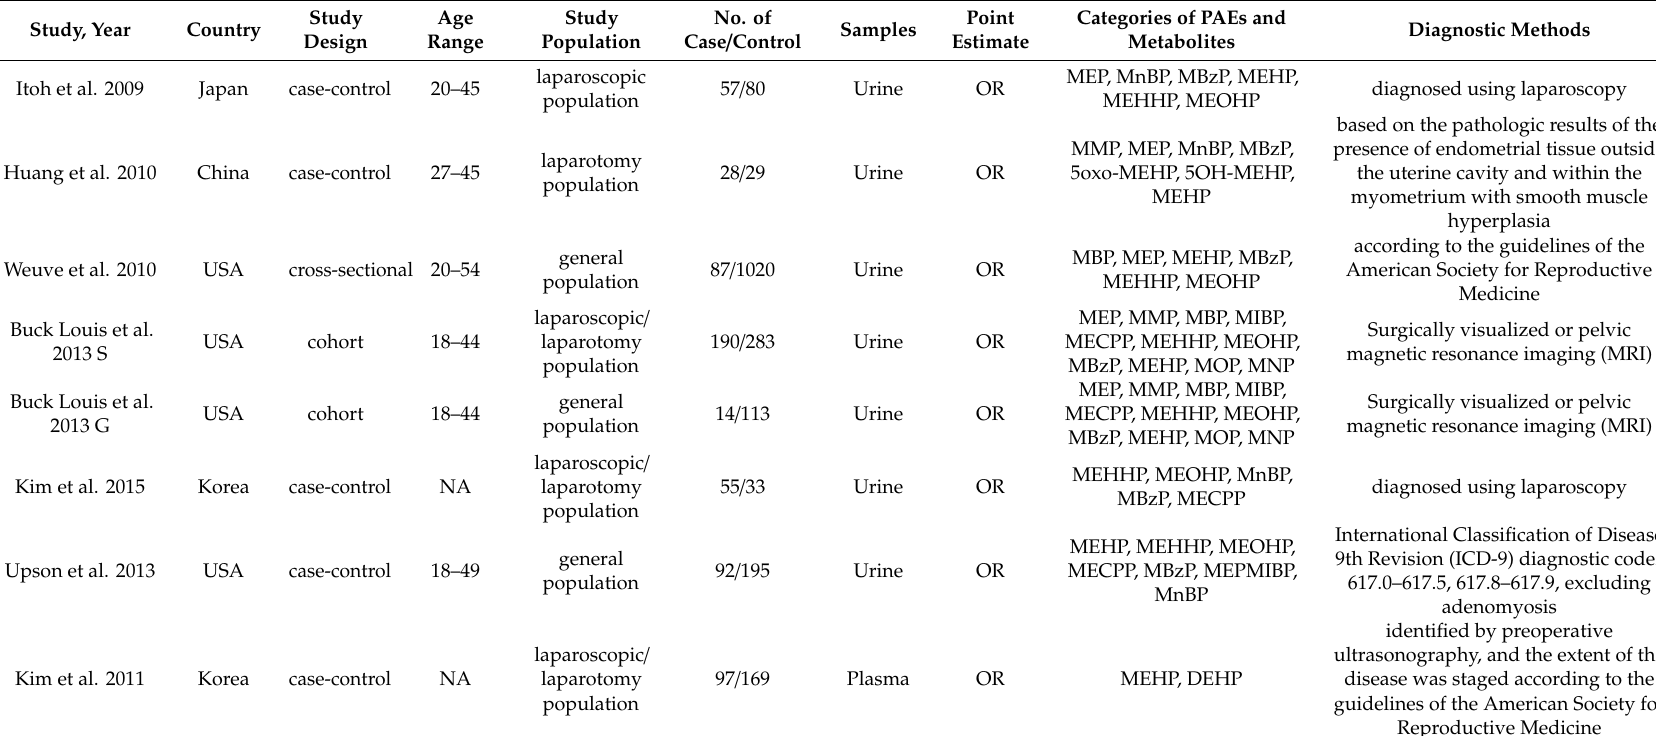
Table 1. Characteristics of studies included in the